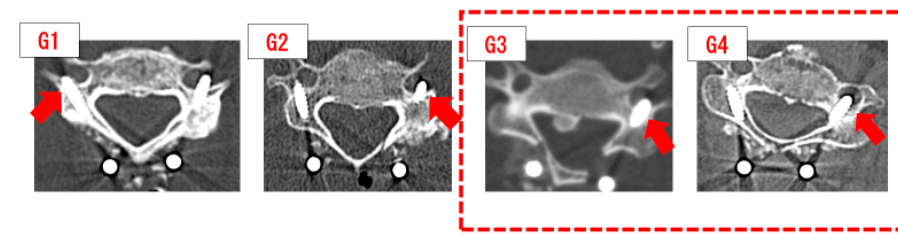
Figure 2. Degrees of screw deviations: ( G1 ) Screw only slightly breaks through the inner side of the vertebral artery; ( G2 ) penetration of less than 1/2 of the screw diameter; ( G3 ) more than 1/2 of the screw diameter has breached the vertebral artery; ( G4 ) the entire screw diameter has breached the vertebral artery.